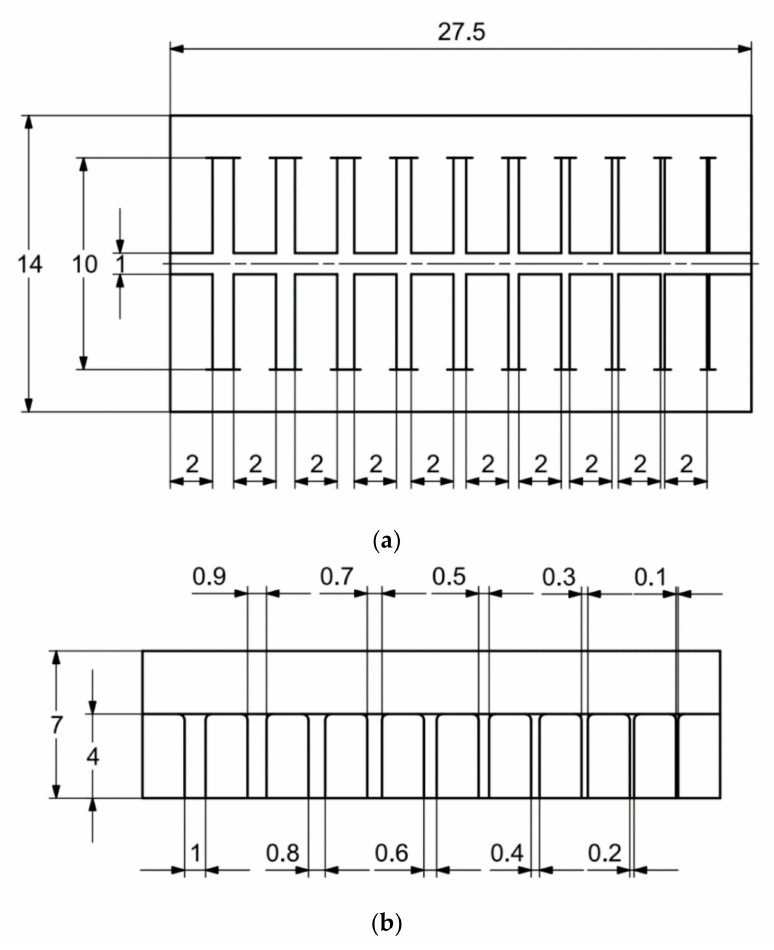
Figure 9. ( a ) The main view of the illustrative drawing of samples covered by the research is marked as MB4. ( b ) The top view of cuboidal objects 1–0.1 mm based on Figure 9a of the main view of an illustrative drawing of samples covered by the research is marked as